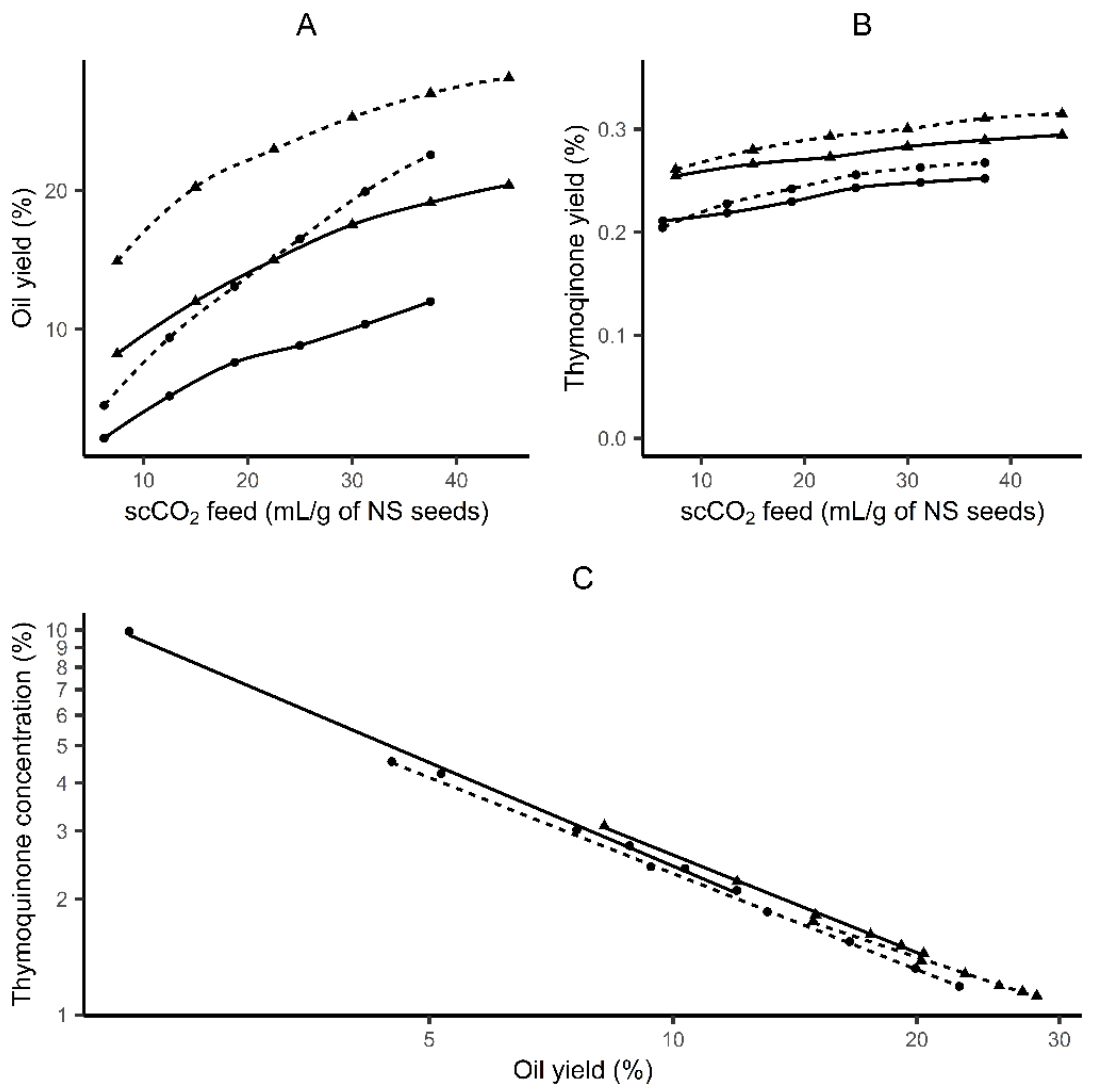
Figure 3. Relationship between NS seed oil yield and scCO 2 feed expressed in mL per g of NS seeds obtained by scCO 2 extraction at temperature of 40 °C, pressure of 10 (—) and 15 MPa (- - -) scCO 2 flow of 5 (•) and 10 mL/min ( ▲ ) ( A ). Relationship between thymoquinone extraction yield and scCO 2 feed expressed in mL per g of NS seeds obtained by scCO 2 extraction at fixed temperature of 40 °C, pressure of 10 (—) and 15 MPa (- - -) and scCO 2 flow of 5 (•) and 10 mL/min ( ▲ ) ( B ). Relationship between N. sativa oil yield and thymoquinone concentration (%, w / w ) in oil during supercritical CO 2 extraction at temperature of 40 °C, pressure of 10 (—) and 15 MPa (- - -) and scCO 2 flow of 5 (•) and 10 mL/min ( ▲ ) (C). Mean values for three replicates were plotted.